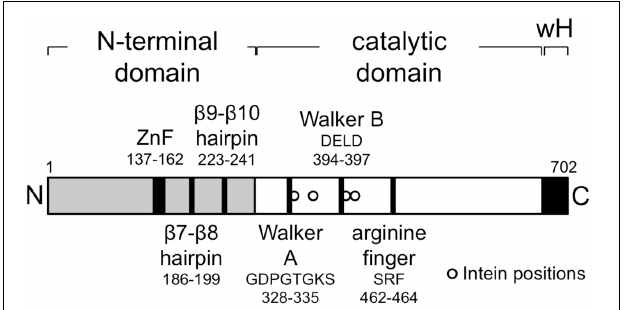
FIGURE 2 | The Haloferax volcanii MCM protein. Schematic representation showing domain organization of the Hfx. volcanii MCM protein, highlighting the location of key structural motifs. The locations of intein insertions (from right to left, inteins A–D, see Table 1 ) in other haloarchaeal MCM proteins (not in Hfx. volcanii MCM, which is intein-free) are indicated by the open circles at positions 335, 362, 401, and 415.